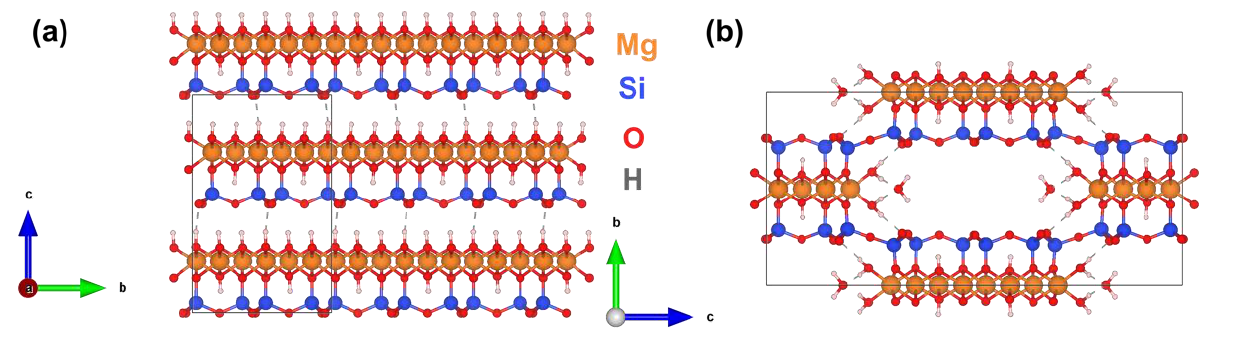
Figure 3. Crystal structures of ( a ) chrysotile and ( b ) sepiolite used in DFT calculations. Visualization was carried out using the VESTA 3 program [52]. The ‘b’ and ‘c’ letters denote crystallographic axes. The Mg:Si ratio in sepiolite layers (2:3) is the opposite to that found in the chrysotile layers (3:2); therefore, part of the layer material was amorphized, leading to an additional contribution to the endothermic effect and disturbing the crystal structure (Figure 4) of the sample. Dehydroxylation occurred partially because it was necessary to ensure the structural stability of the sepiolite-like phase. Further weight loss in the 650 to 800 ◦ C temperature range (Figure 2) was caused again by dehydroxylation, but of the sepiolite-like phase. A sharp exothermic effect at temperatures of above 800 ◦ C corresponded to the crystallization of magnesium silicates, mainly in the form of Mg 2 SiO 4 forsterite